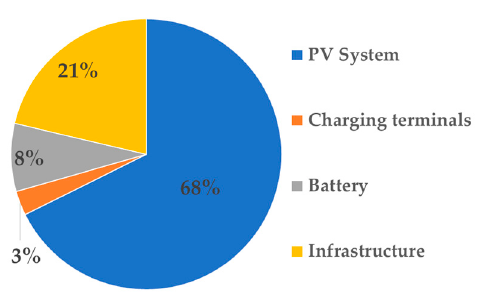
Figure 6. Distribution of carbon impact of the PVCS without considering the power grid.